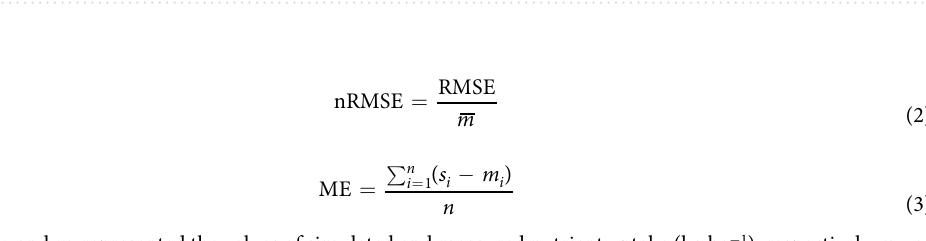
Table 1. Characteristics of the experimental sites and the soil properties in the radish-producing regions of